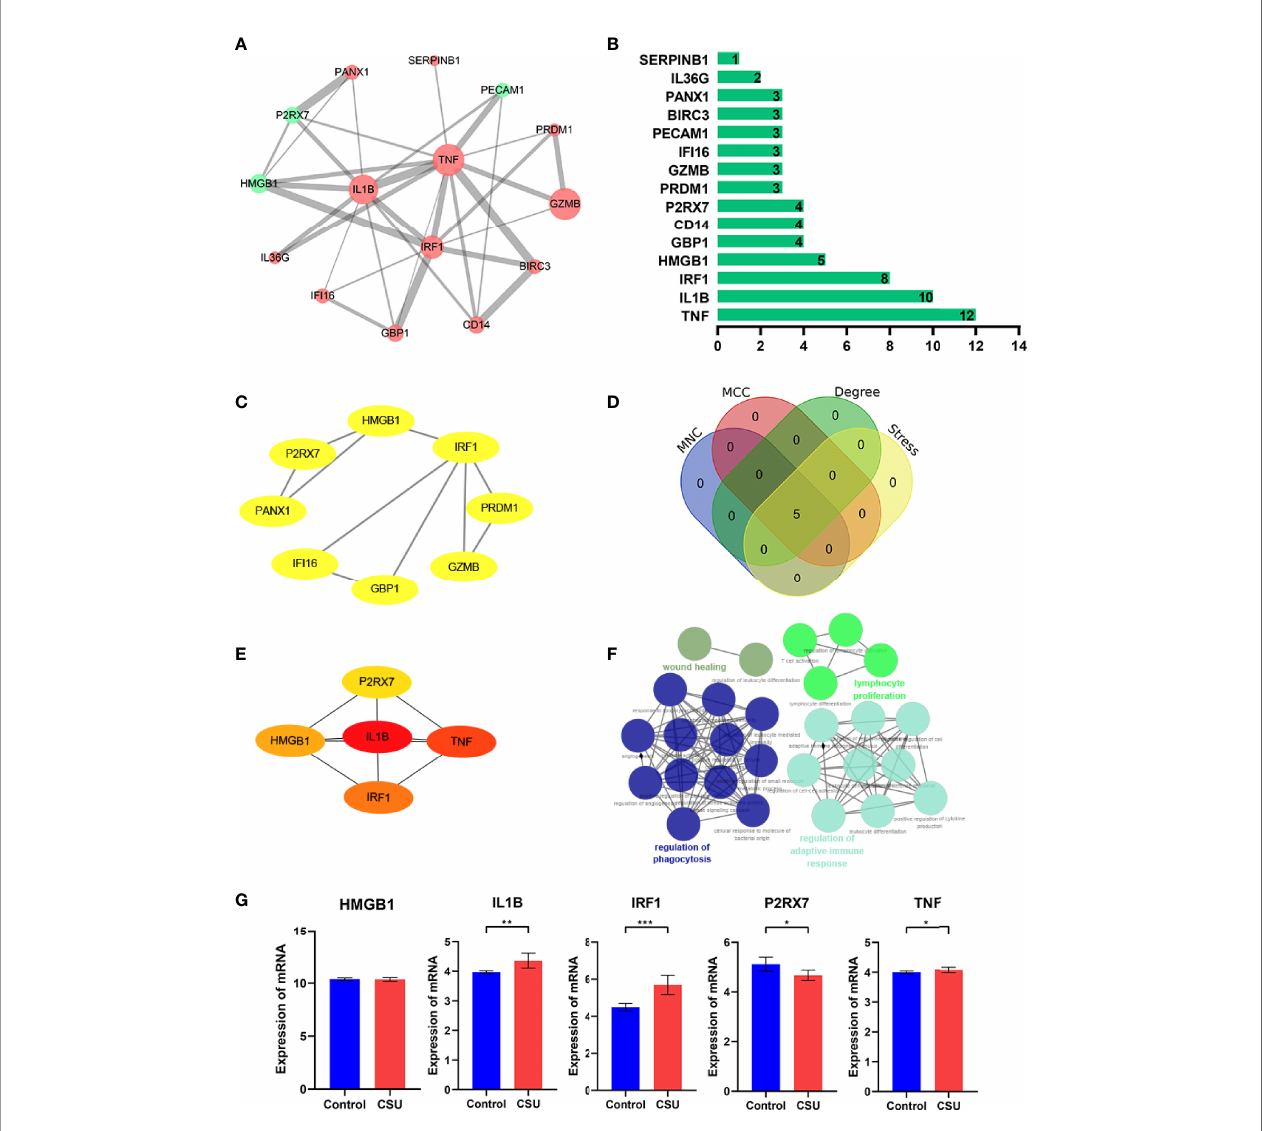
FIGURE 4 | The PPI network and hub gene analyses. (A) The PPI network of the DEPRGs, the bigger sizes of the edge and node mean the higher degree. The red means upregulated, and green means downregulated. (B) The connectivity rank of genes. (C) The fi rst module of the PPI network. (D) Four algorithms were utilized to identi fi ed hub genes. (E) 5 hub genes of CSU. (F) The biological process of hub genes via the ClueGO tool. (G) Data validation of hub genes by GSE57178. *P < 0.05; **P < 0.01; ***P < 0.001.